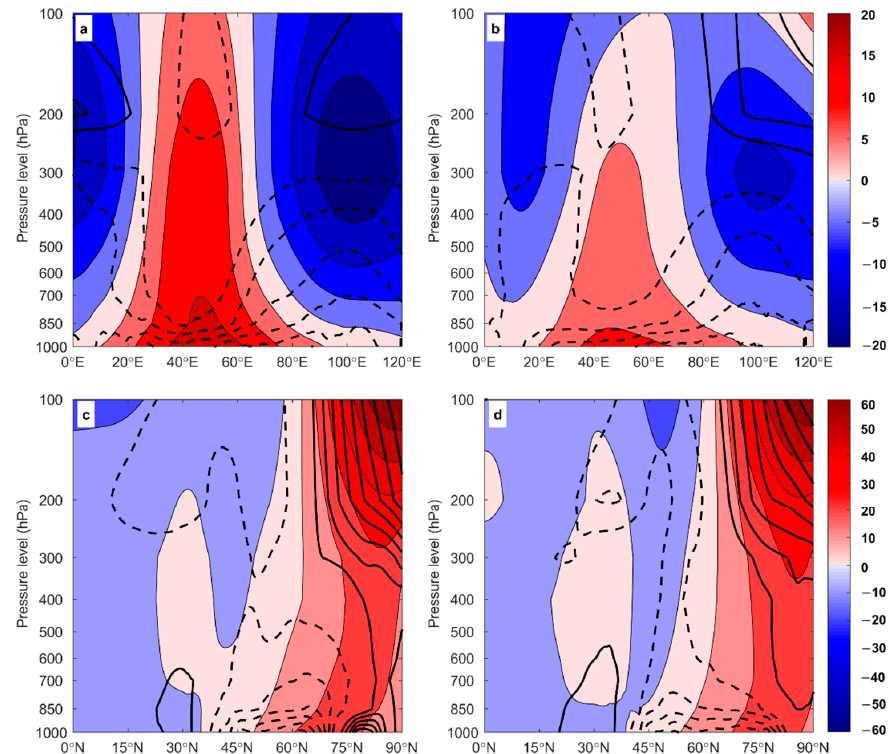
Figure 12. Longitude-altitude profile ( a , b ) and latitude-altitude profile ( c , d ) of the synthetic HGT(shadings, unit: gpm) and T(contour lines, unit: °C) anomaly field (low ( a , c ) SI years in the Barents-Kara Sea region; low ( b , d ) SI years in the Chukchi Sea region) (black solid contour lines mean positive T anomaly, black dashed contour lines mean negative T anomaly, the contour lines interval is 0.2 °C).